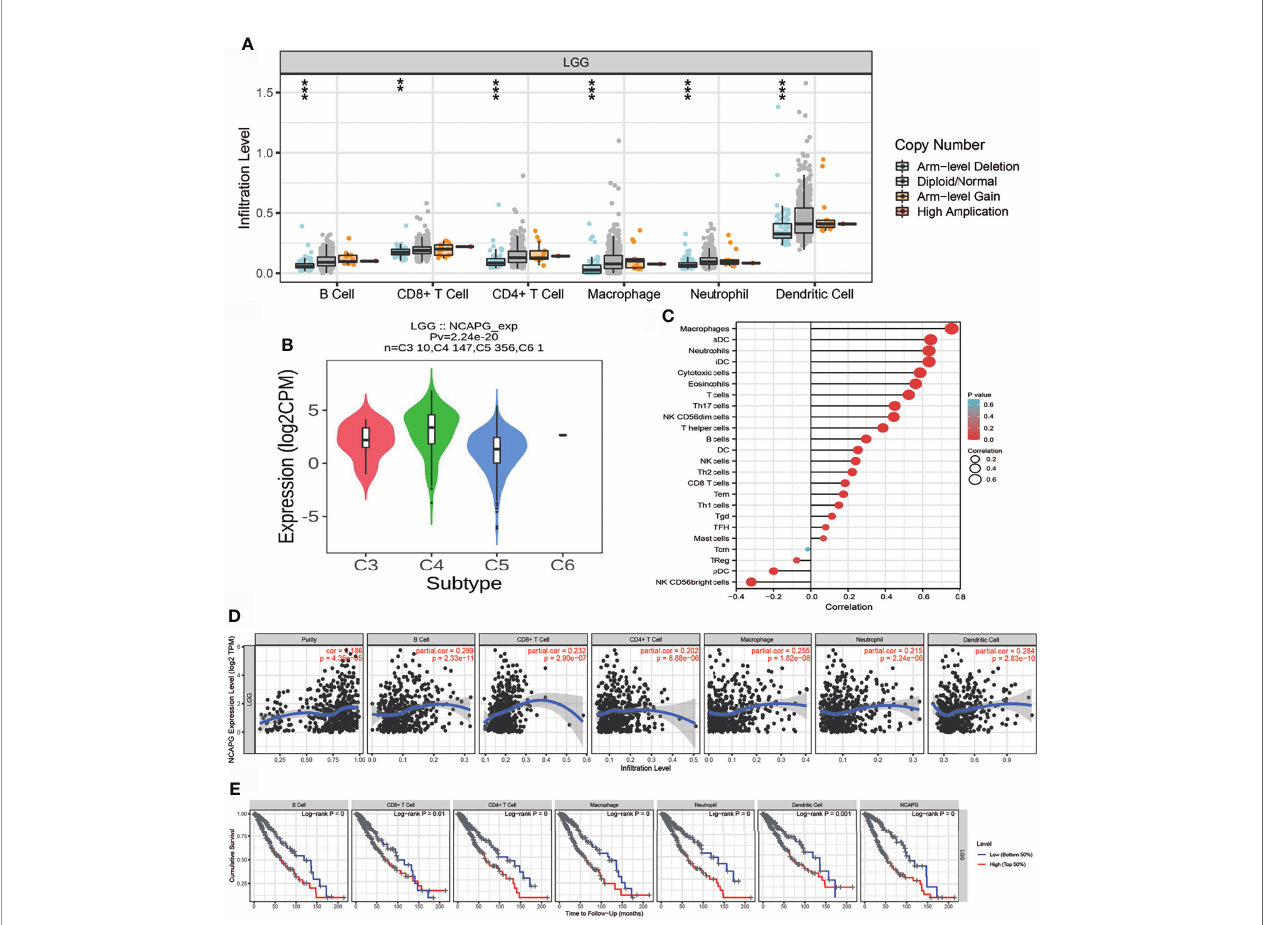
FIGURE 7 | Analysis of the correlation between NCAPG expression and immune cell in fi ltration. (A) The correlation between NCAPG expression and somatic copy number alterations. (B) The expression of NCAPG in various immune subtype. (C, D) The correlation between NCAPG expression and the in fi ltration of different immune cells. (E) Levels of B cells, CD4+ T cells, CD8+ T cells, dendritic cells, macrophages, and neutrophils are correlated with the cumulative survival rate in glioma. ** p < 0.01, ***p <